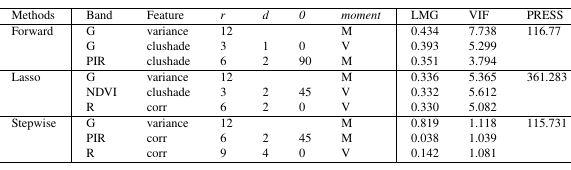
Table 5: Comparison of subset selection methods in retrieving ages from multispectral data ( n = 12 ) quality of predictions in all cases including the basal area com- pared to single regressions (Table 3). One can observe that most